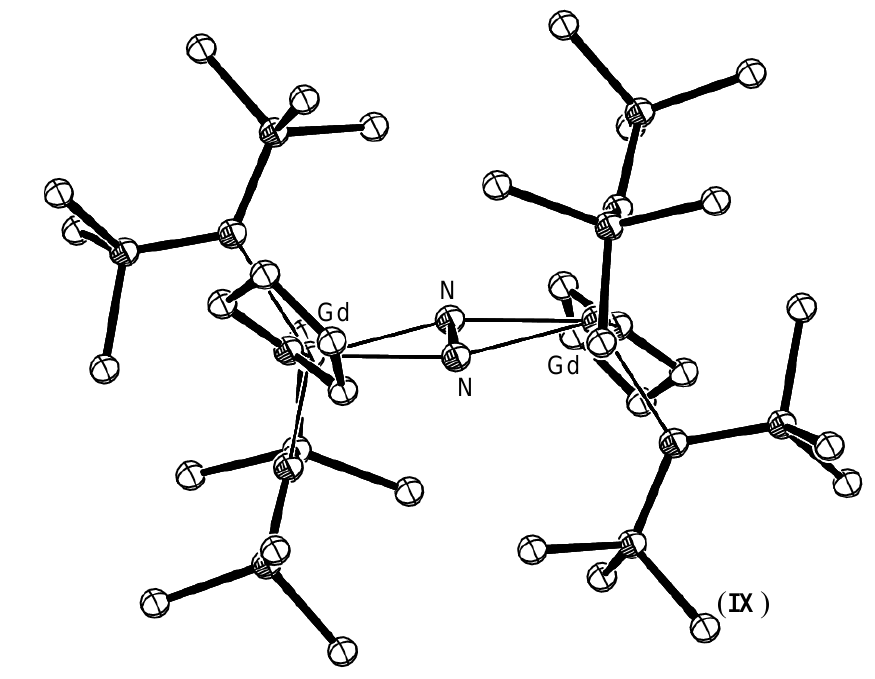
Figure 4. Reduced dinitrogen Gd complex, [{(THF)Gd(N(SiMe Disorder in one TMS group is not shown. Figure generated from CCDC obtained coordinates. Atoms of arbitrary size. H atoms omitted for